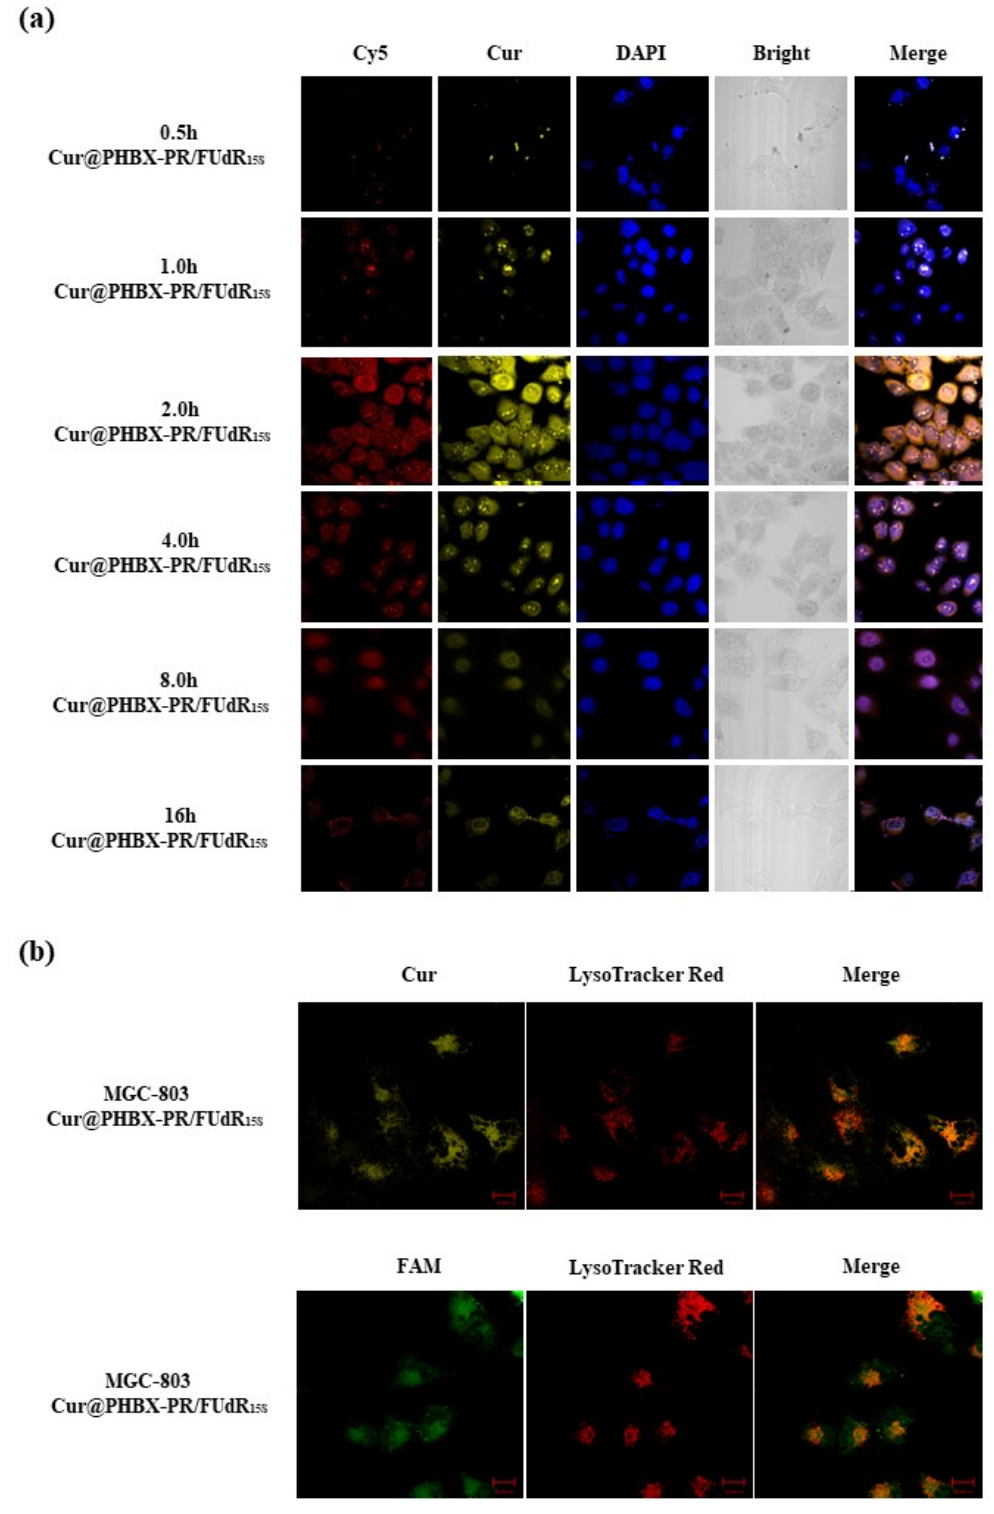
Figure 4. Cellular uptake and localization of gastric cancer MGC 803 cells. ( a ) Confocal laser scanning microscope images of MGC 803 cells treated with Cur@PHBX-PR/FUdR 15S labelled by Cy5-FUdR 15S and Cur at different times (relative to Cy5 = 6 × 10 − 6 M). ( b ) Co-localization studies of Cur@PHBX-PR/FUdR 15S carried out using lysosome tracker in MGC 803 cells after incubation for 0.5 h. Scale bar: 20 μ m.